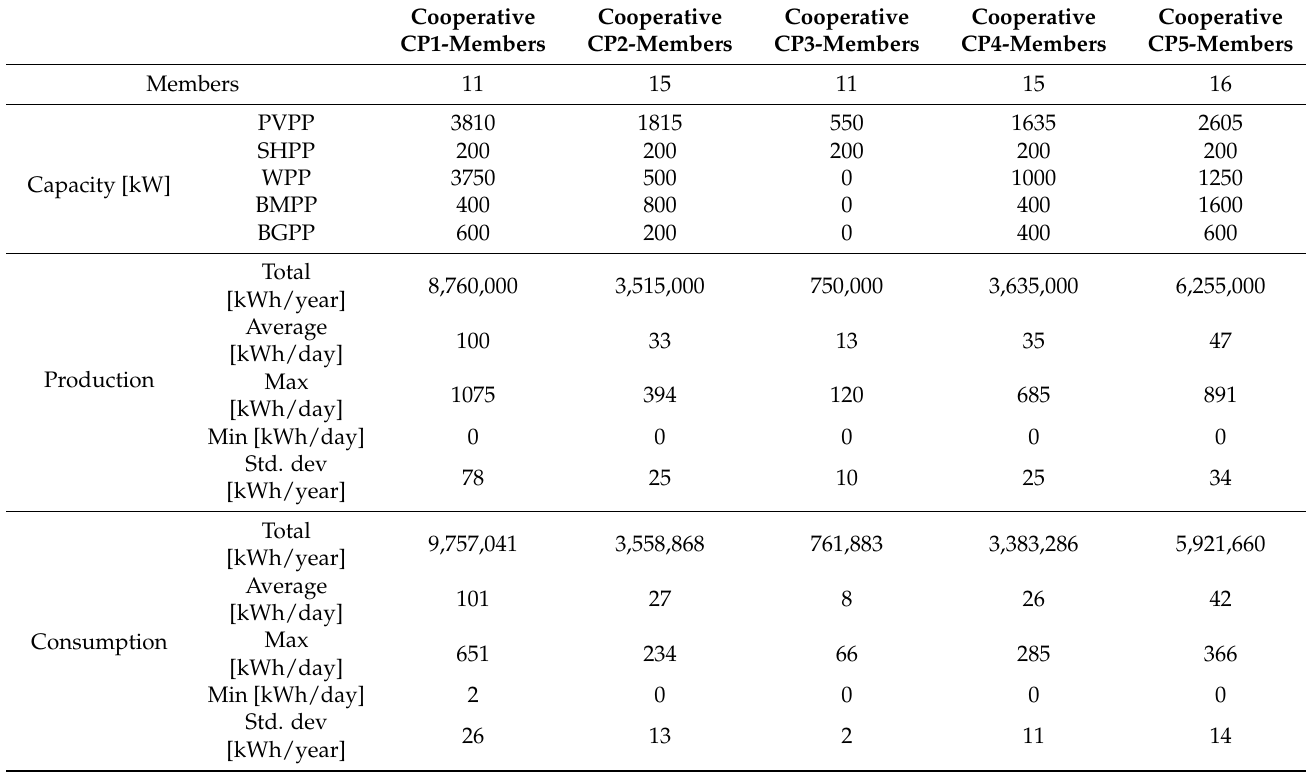
Table 2. Information concerning farms (prosumers and energy consumers) before the establishment of the cooperative.